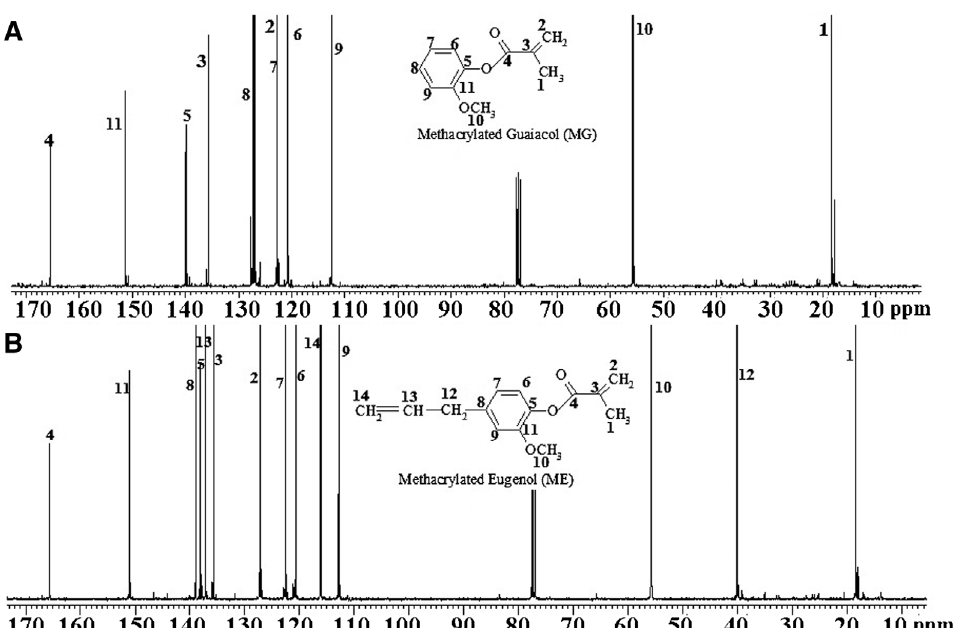
Figure 5: 13 C-NMR of (A) ME and (B) MG.